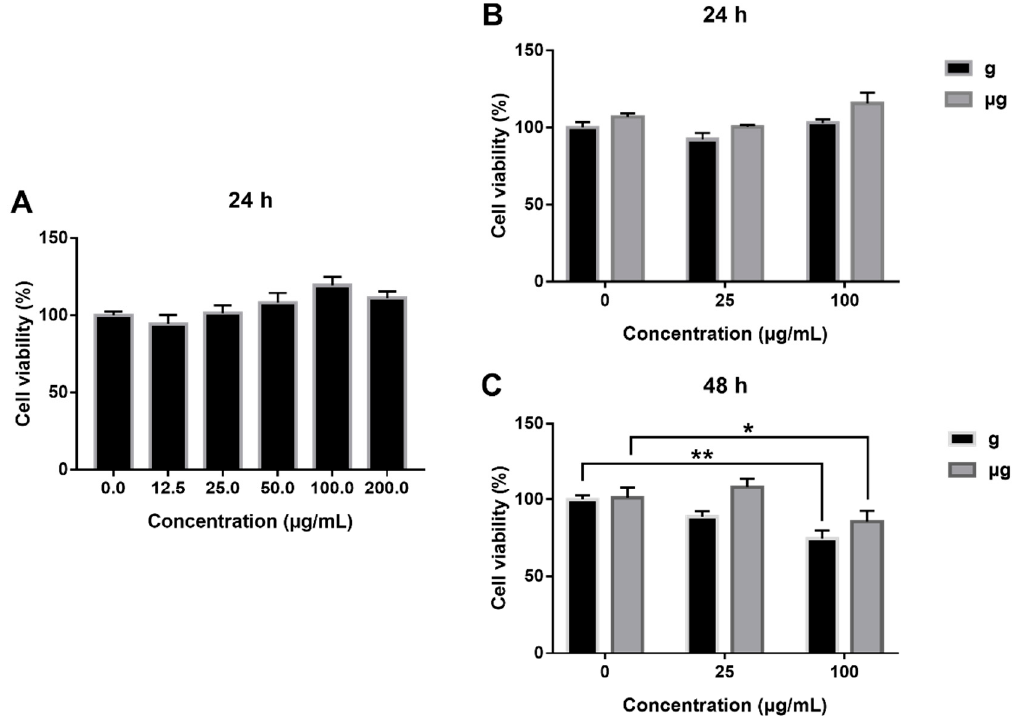
Figure 2. Effect of TiO 2 NPs exposure on A549 cell viability. A549 cells were treated with TiO 2 NPs (0, 12.5, 25, 50,100 and 200 µ g/mL) for 24 h under normal gravity ( A ). And cells were treated with TiO 2 NPs (0, 25 and 100 µ g/mL) for 24 h ( B ) or 48 h ( C ) under normal gravity (g group) or simulated microgravity ( µ g group). Cell viability was measured using Cell Counting Kit-8 assay. * p < 0.05, ** p < 0.01.